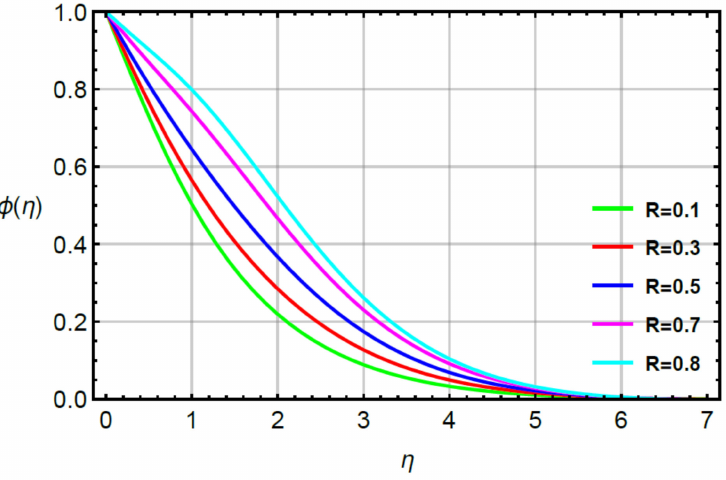
Figure 12. Behavior of φ ( η ) for R when Sc = 0.6, α 1 = 0.2 = α 2 , γ 2 = 0.3, M = 0.1, δ = 0.8.